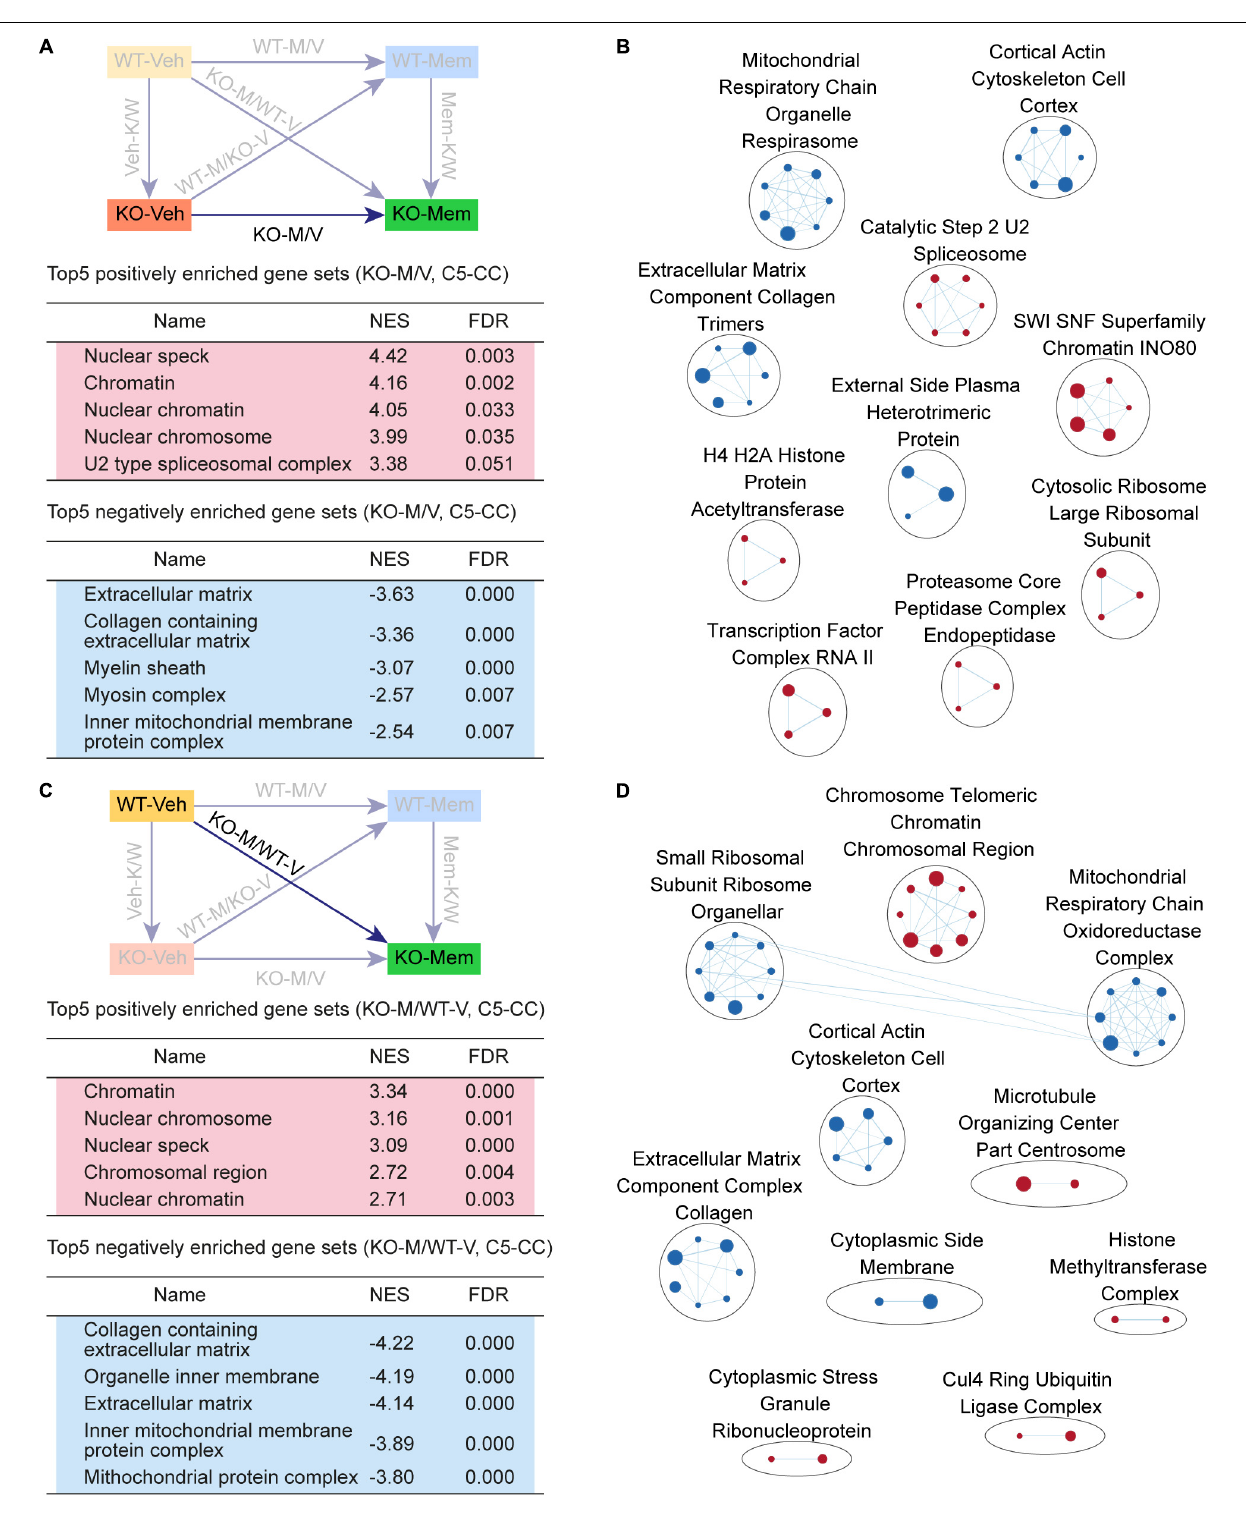
FIGURE 4 | Gene Set Enrichment Analysis of KO-M/V and KO-M/WT-V transcripts for biological functions. (A,B) GSEA results for KO-M/V transcripts showing a list of the top five positively (red) and negatively (blue) enriched gene sets in the C5-CC domain (A) and their integrated visualization generated using EnrichmentMap (B) . See Supplementary Figure 3 for GSEA C5-BP/MF results. [ n = 3 mice (KO-Veh, KO-Mem), FDR < 0.05]. (C,D) GSEA results for KO-M/WT-V transcripts showing a list of the top five positively (red) and negatively (blue) enriched gene sets in the C5-CC domain (C) and their integrated visualization generated using EnrichmentMap (D) . See Supplementary Figure 4 for GSEA C5-BP/MF results. [ n = 3 mice (WT-Veh, KO-Mem), FDR <